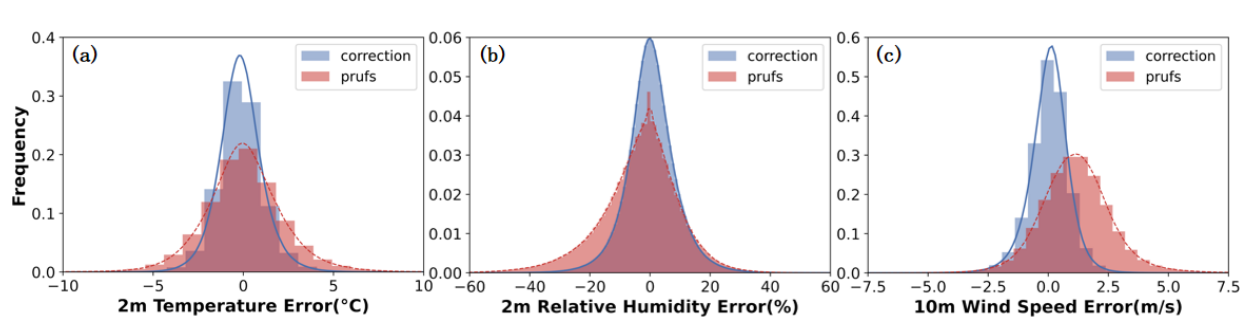
Figure 4. Normalized frequency distributions of the PRUFS forecast errors and the G2N corrected forecast errors. The ( a ) 2 m temperature, ( b ) 2 m relative humidity, and ( c ) 10 m wind speed, with error bins at 1 °C, 1%, and 0.5 m/s, respectively.